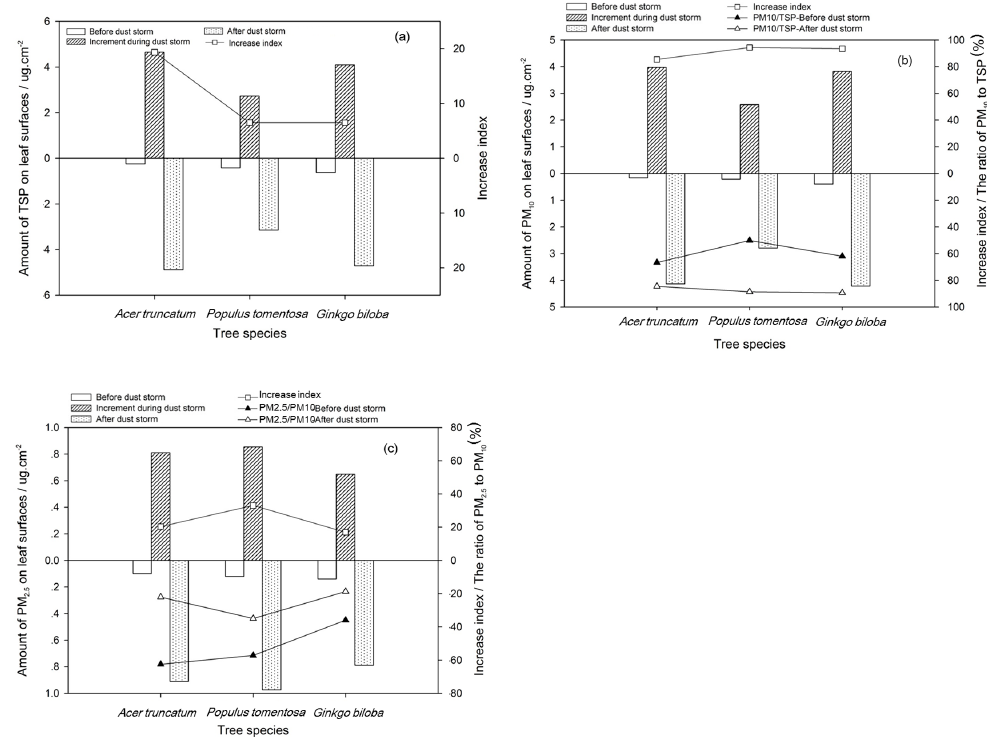
Figure 11. Total suspended particulate matter (TSP) ( a ), PM 10 ( b ) and PM 2.5 ( c ) on the leaf surfaces of the deciduous tree species before and after dust storm and its increase index.